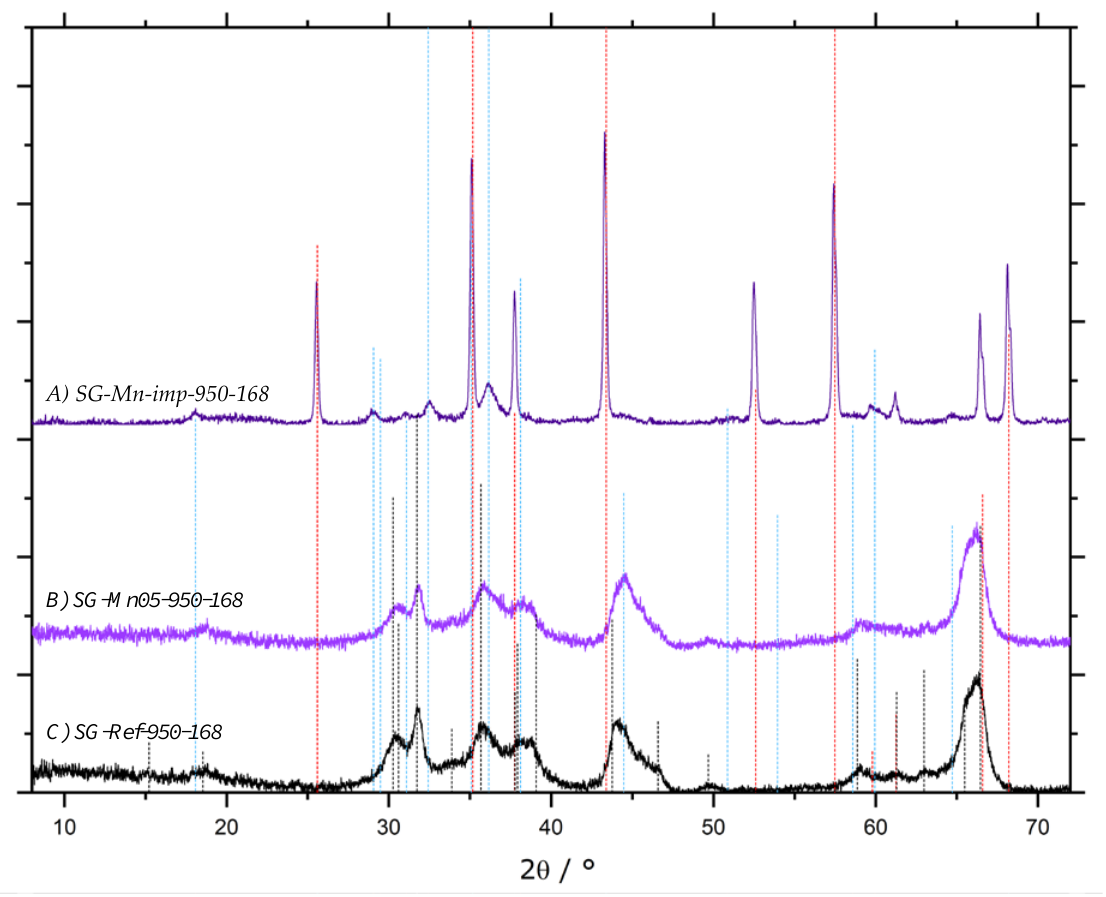
Figure 15. XRD patterns of sol-gel samples calcined at 950 ◦ C for 168 h. Sample SG-Mn-imp950-168 ( A ), impregnated with manganiferous precursor exhibits all reflexes of α -Al 2 O 3 , along with hausmannite Mn 3 O 4 , and some remaining θ -Al 2 O 3 , while the pure alumina sample SG-Ref0-950-168 ( C ) shows a pattern of a poorly crystallized θ -Al 2 O 3 . The same holds true for sample SG-Mn05-950-168 ( B ), synthesized from 95 mol-% Al- and 5 mol-% Mn-precursors. Red dotted lines indicate α -Al 2 O 3 , black dotted lines indicate θ -Al 2 O 3, hausmannite reflexes are marked in blue.